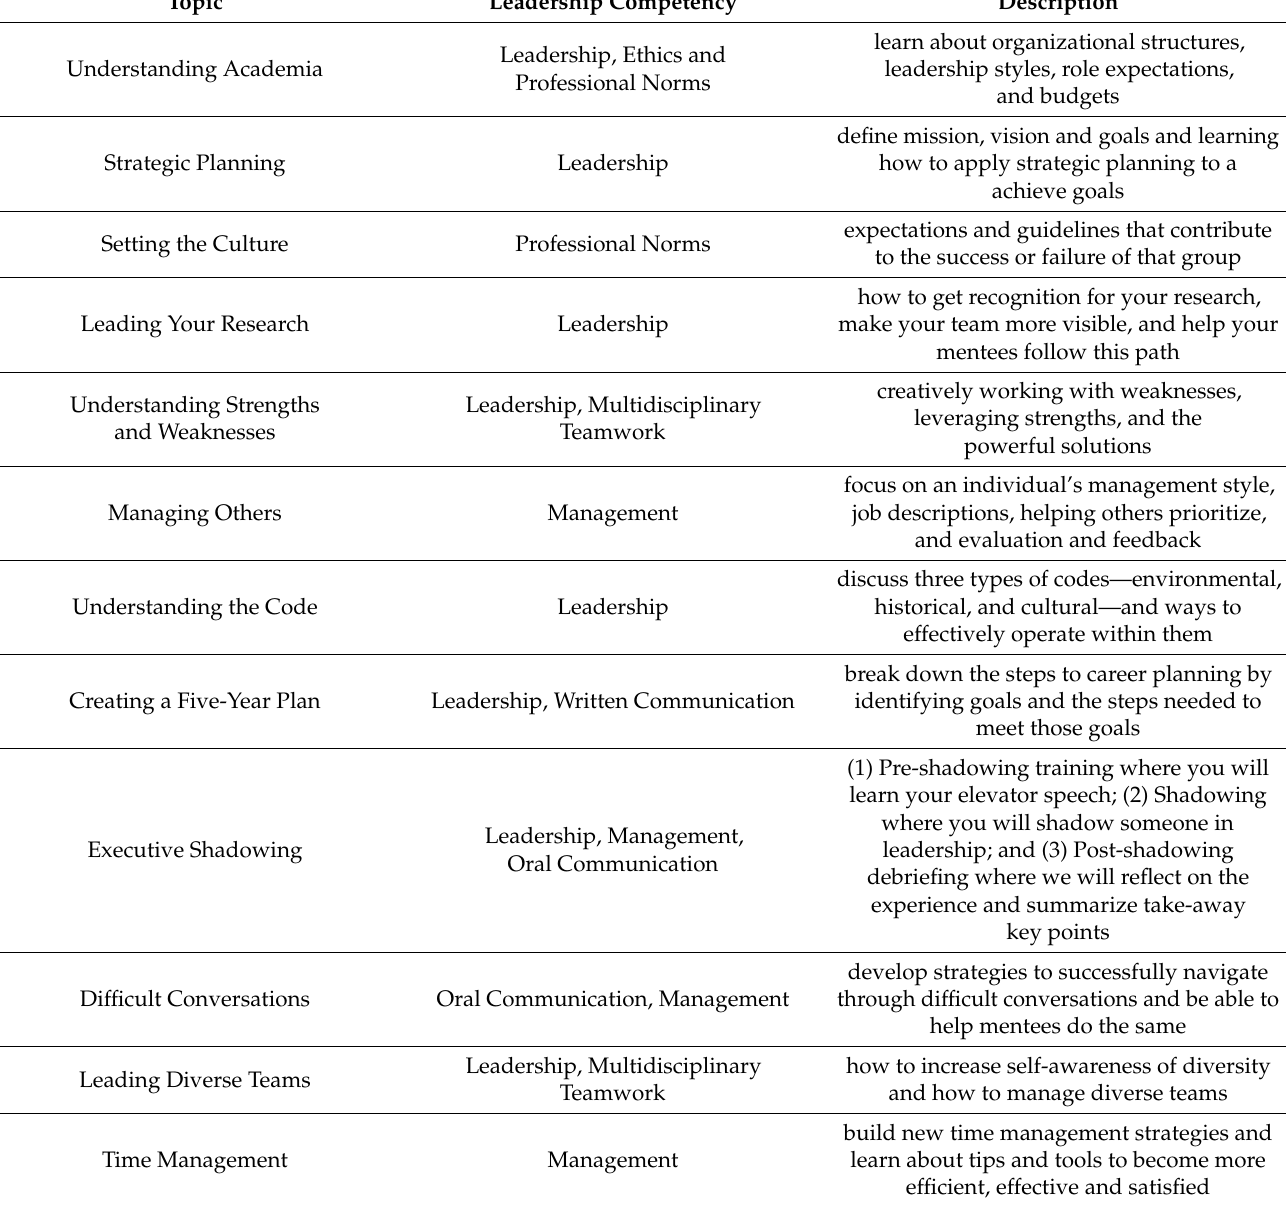
Table 1. Modules for leadership skill